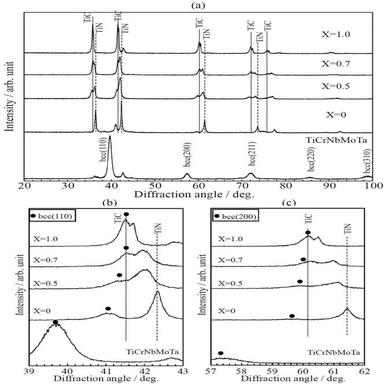
XRD patterns of TiCXN1-X-TiCrNbMoTa specimens.